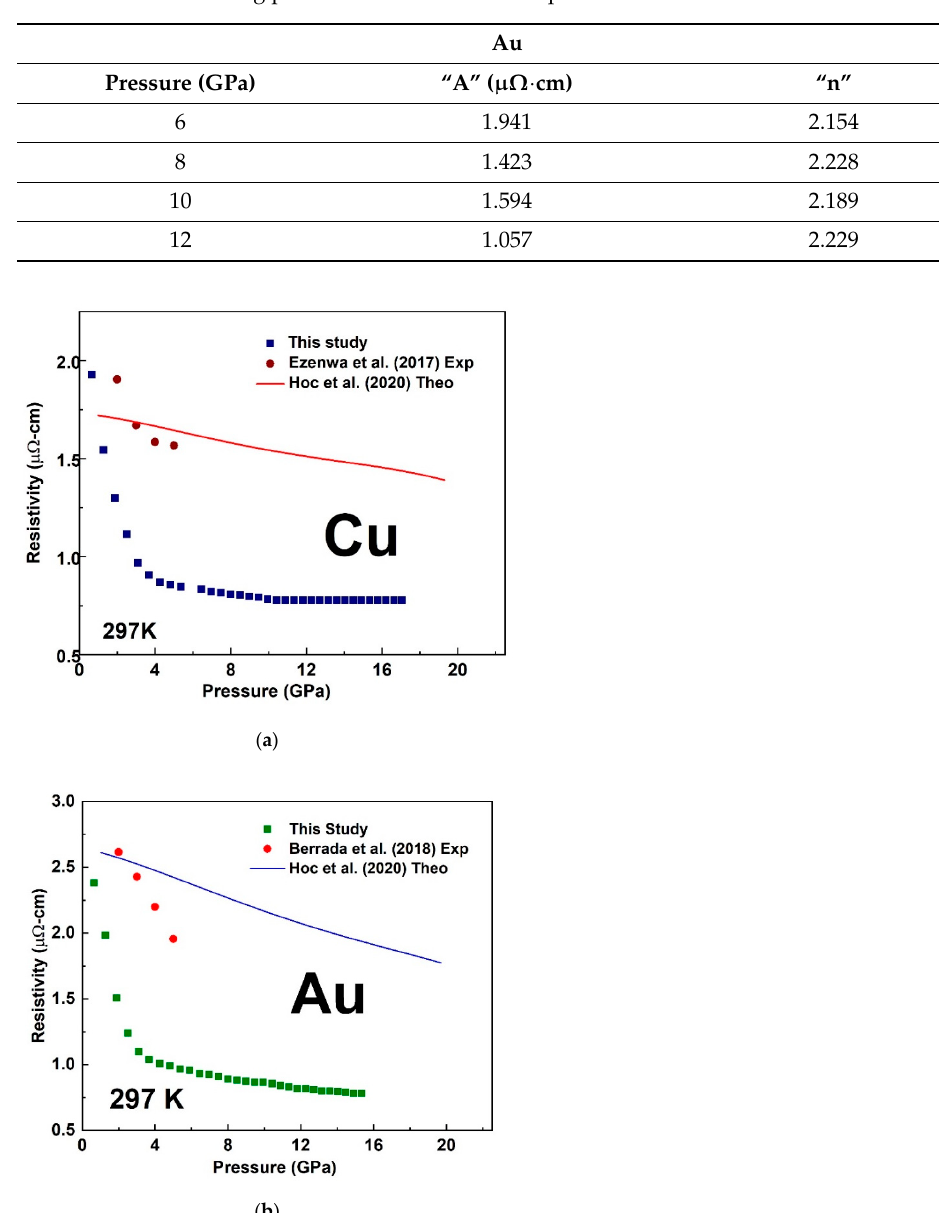
Figure 6. ( a ) is the pressure dependent resistivity of Cu measured up to 17 GPa, while ( b ) is that of Au measured up to 16 GPa at room Temperature compared with experimental [10,12] and theoretical [20] data.